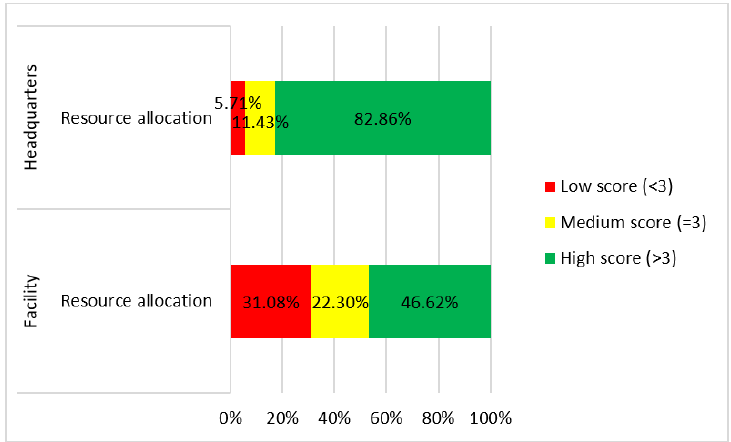
Figure 12. Categorized BARS percentages for formalization, by location.